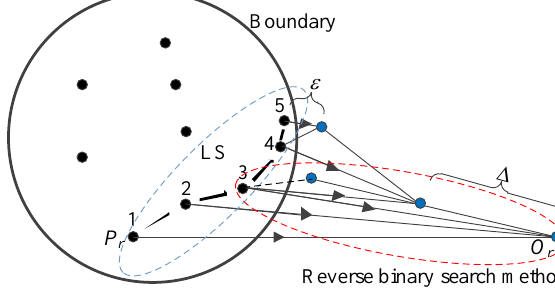
Figure 9. The process of the Local search.